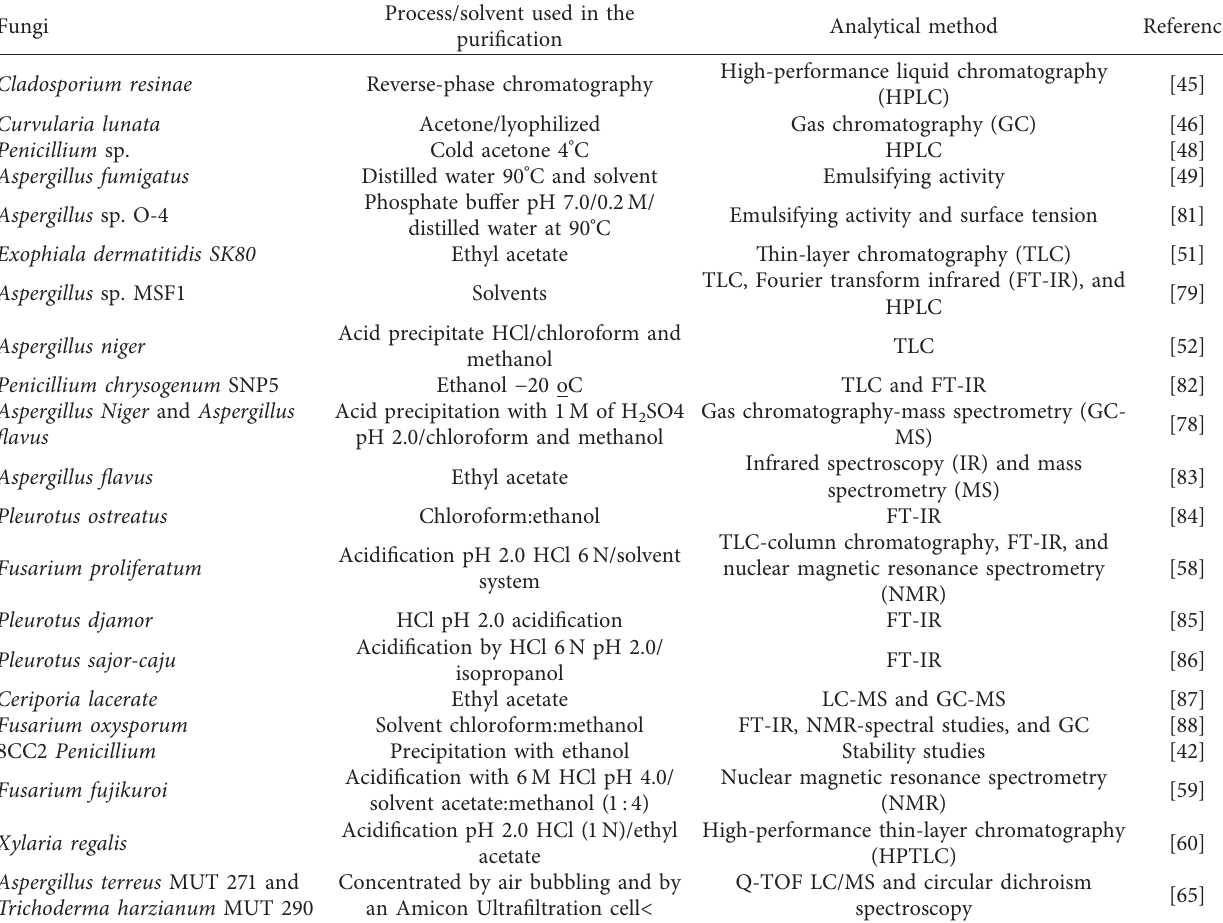
Table 3: Types of biosurfactant extraction and characterization from filamentous